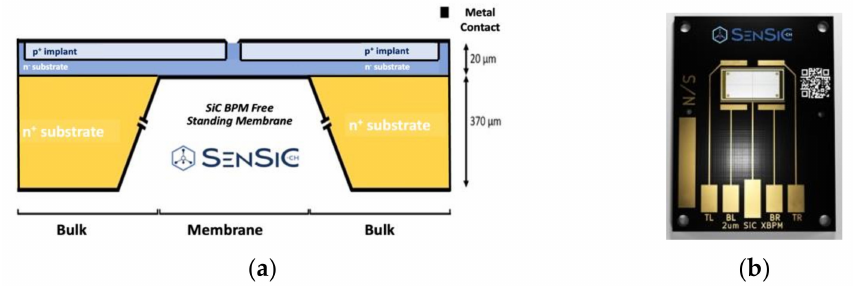
Figure 1. Schematic overview ( a ) and picture ( b ) of a SiC detector developed by the SenSiC company. As an example, a SiC sensor with 20 µ m active thickness and the 370 µ m substrate is shown along with the possible “free standing membrane” configuration where the substrate is